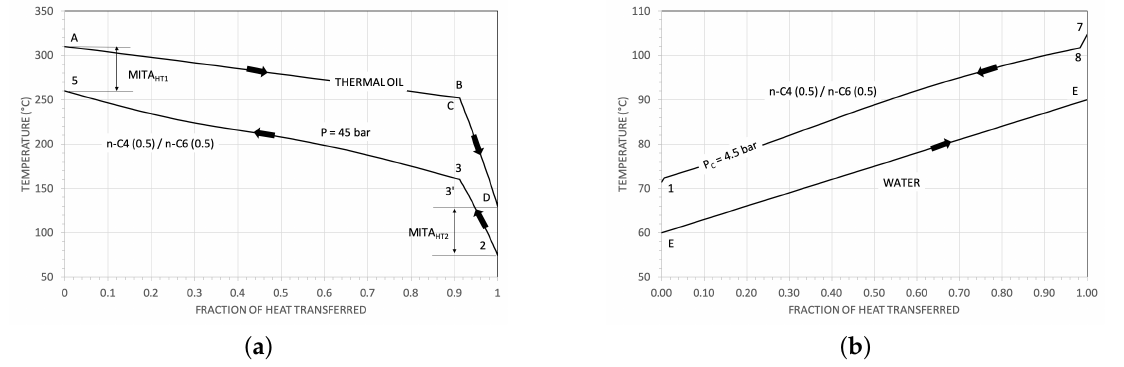
Figure 8. Temperature - Thermal power exchanged ( T − ˙ Q diagrams) for the the equimolar mixture n-C4/n-C6. ( a ) in the hot oil heat exchangers. ( b ) in the condenser.